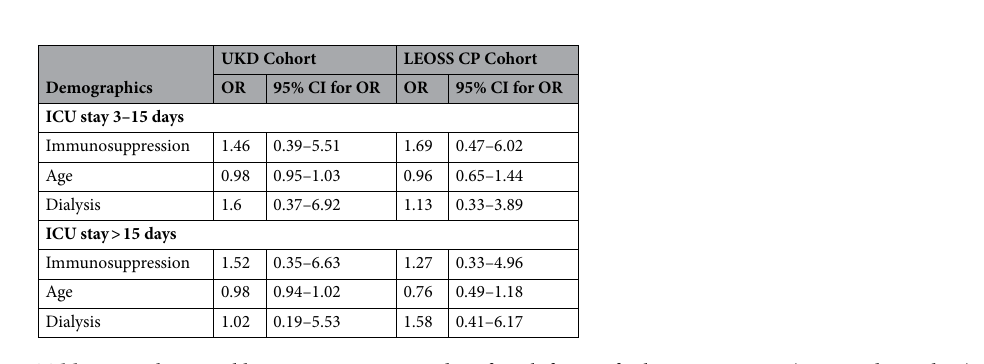
Table 5. Multinomial logistic regression to identify risk factors for longer ICU stay (3–15 and > 15 days). * p < 0.05, ** p < 0.01, *** p < 0.001; UKD University Hospital Düsseldorf, OR odds ratio, CI confidence interval, UC uncomplicated, CO complicated, CR critical